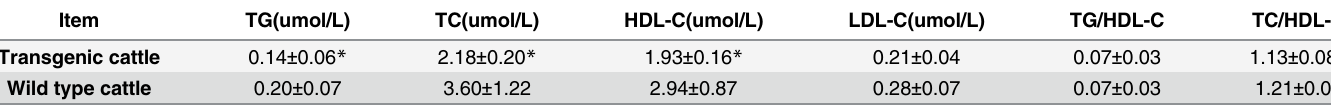
Table 1. A comparison of the biochemical indexes of the blood lipids between fat-1 transgenic and wild-type cattle.